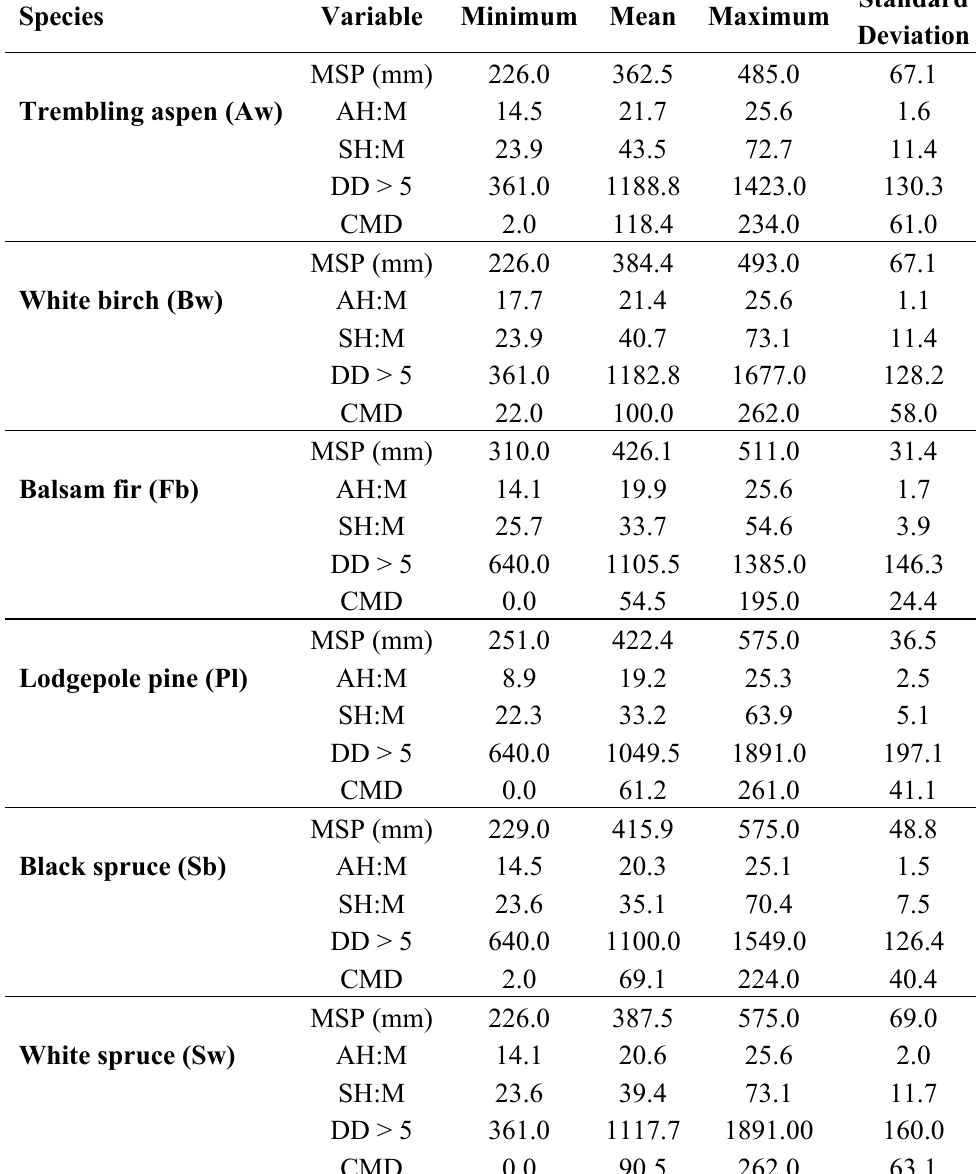
Table 3. Basic statistical information of selected climate variables for each tree